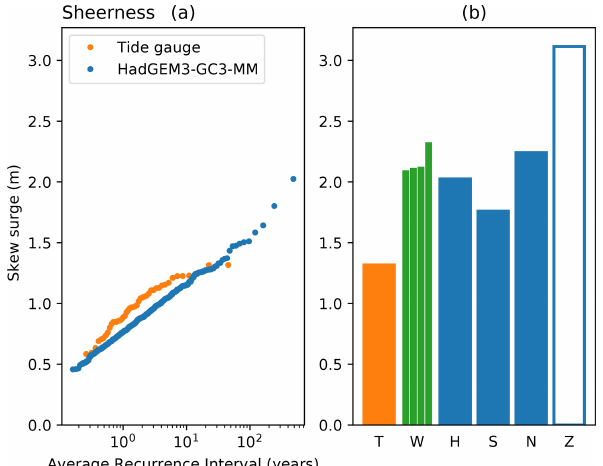
Figure 7. Observed (orange), estimated (green), and modelled (blue) skew surges at Sheerness. (a) Empirical return level plot showing annual maxima of skew surge from tide gauge data as used in CFB2018 (orange) and from the 483-year model simula- tion (blue). Years with less than 75% of available data are excluded from the tide gauge data analysis. (b)) Skew surge maxima. Key: T(ide): tide gauge (max from panel a ). W(adey): data from four different sources for the 1953 event, as tabulated by Wadey et al. (2015). H(adGEM3): model max skew. Phase relationship between atmospheric events and astronomical tide is essentially random over the 483-year simulation. S(pring): model max skew when events are artificially shifted to coincide with spring tide. N(eap): model max skew when events are artificially shifted to coincide with neap tide. Z(ero): model max skew when astronomical tides are excluded (surge-only simulation: “Zero